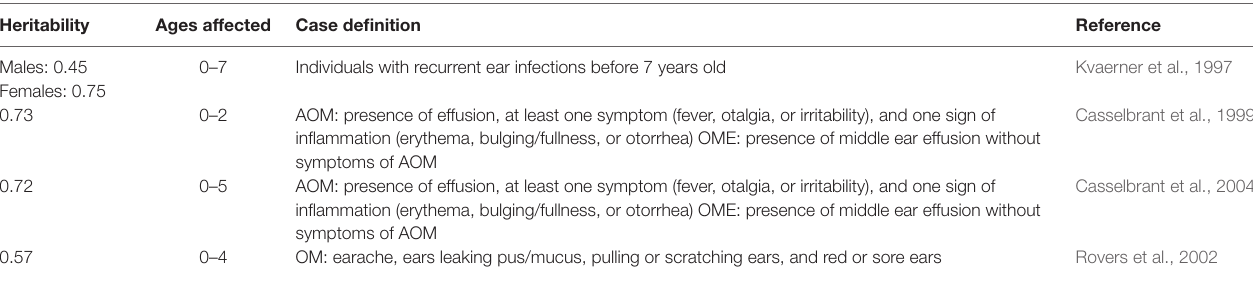
TABLe 1 | Significant heritability values from various twin and triplet